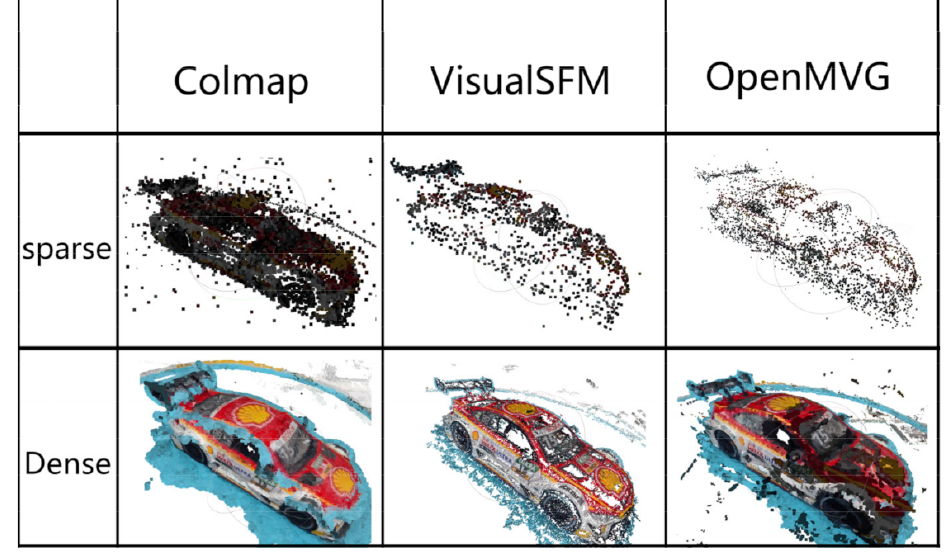
Figure 19. The results of experiment